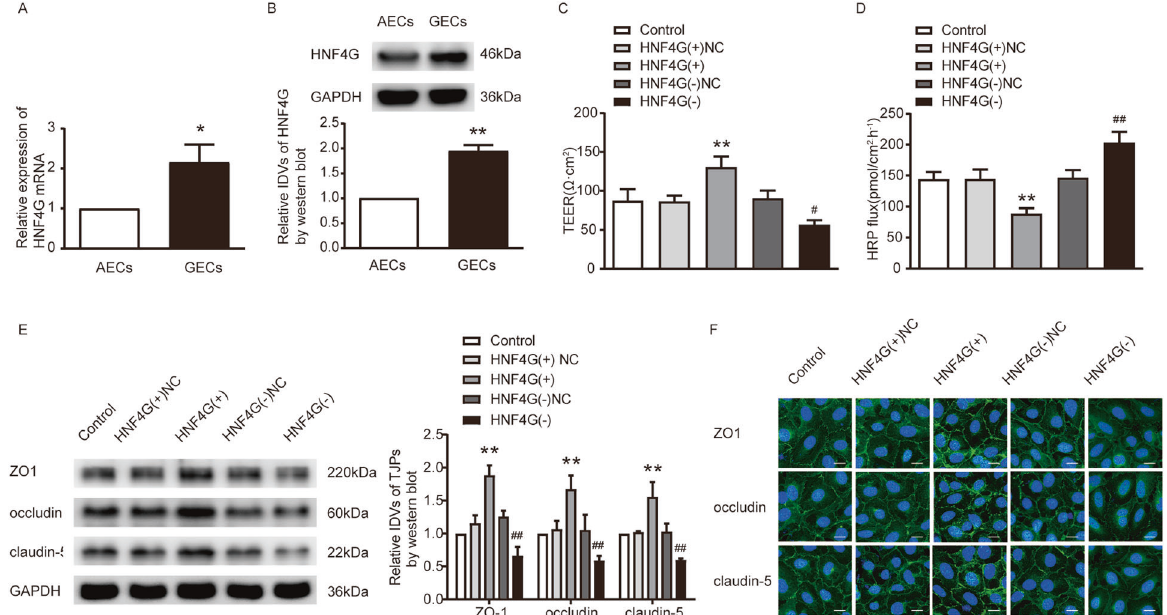
Fig. 5 Knockdown of HNF4G increased BTB permeability in vitro. A , B The mRNA and protein expression levels of HNF4G were up-regulated in GECs than in AECs by qRT-PCR and western blot. Data represent mean ± SD ( n = 3, each). * P < 0.05 vs. AECs group, ** P < 0.01 vs. AECs group. C , D Effects of HNF4G on TEER value and HRP fl ux. Data represent mean ± SD ( n = 3, each). ** P < 0.01 vs. HNF4G( + )NC group, # P < 0.05 vs. HNF4G(-)NC group, ## P < 0.01 vs. HNF4G(-)NC group. E Effects of HNF4G on the expression levels of ZO-1, occludin and claudin-5 determined by western blot. Data represent mean ± SD ( n = 3, each). ** P < 0.01 vs. HNF4G( + )NC group, ## P < 0.01 vs. HNF4G(-)NC group. F Effects of HNF4G on ZO-1, occludin and claudin-5 expression levels and distribution determined by immuno fl uorescence. Scale bar represents 30 μ